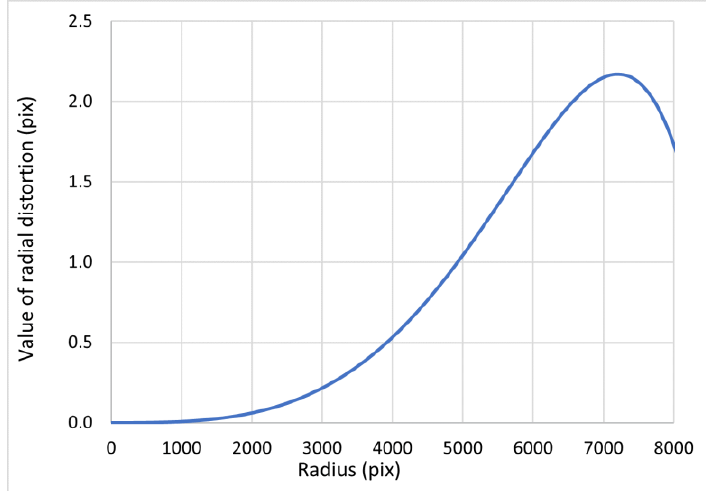
Figure 5. Radial distortion for camera used in re-processing determined by self-calibration in Agisoft Metashape.